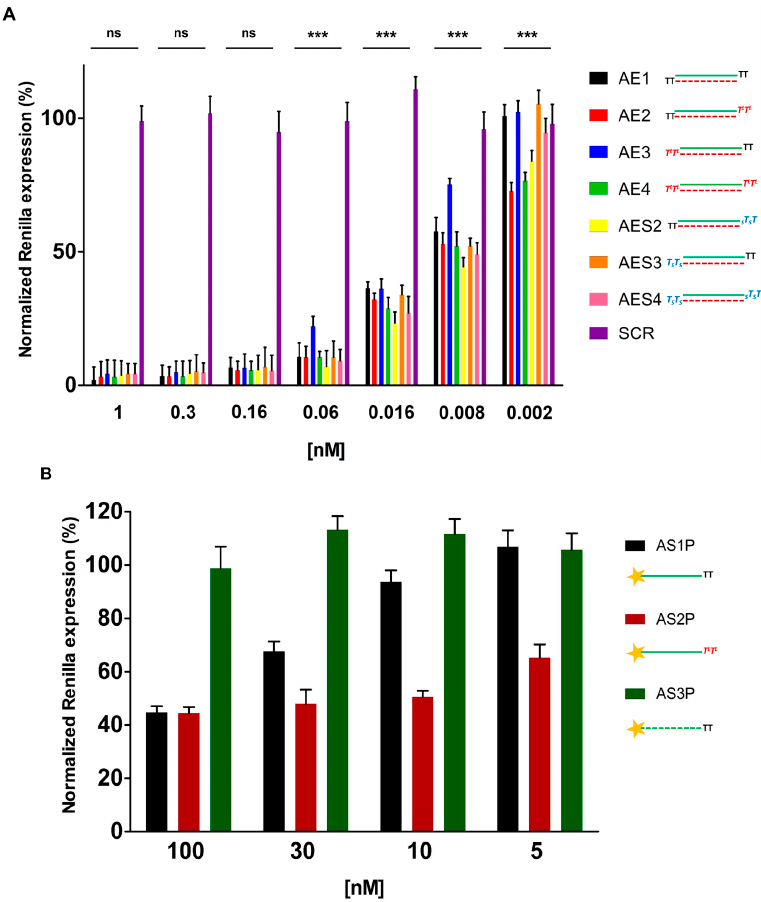
Figure 2. Luciferase assays. ( A ) Dose-response curves of native ( AE1 ), T L modified ( AE2 , AE3 , AE4 ) and PS modified ( AES2 , AES3 , AES4 ) siRNAs. n = 3 ± SD; ( B ) Plot of RNAi activity of native ( AS1P ), 3 ′ -end modified ( AS2P ) and scrambled ( AS3P ) single-stranded antisense siRNAs (ss-siRNA) 5 ′ -phosphorylated. For